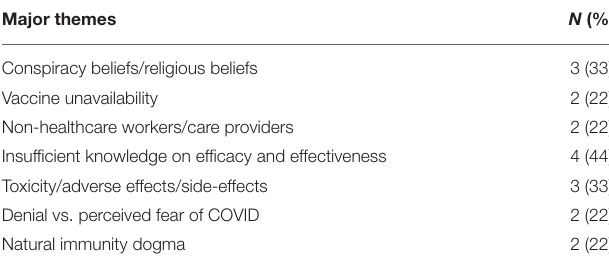
TABLE 2 | Qualitative summary of the findings from VH studies ( N =